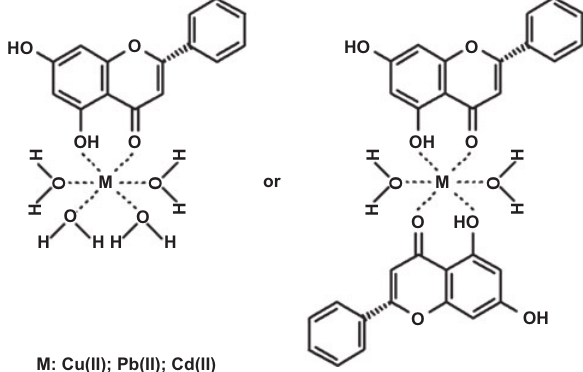
Figure 6 Proposed structure of grafted metal ions onto the PolyCr/GC electrode